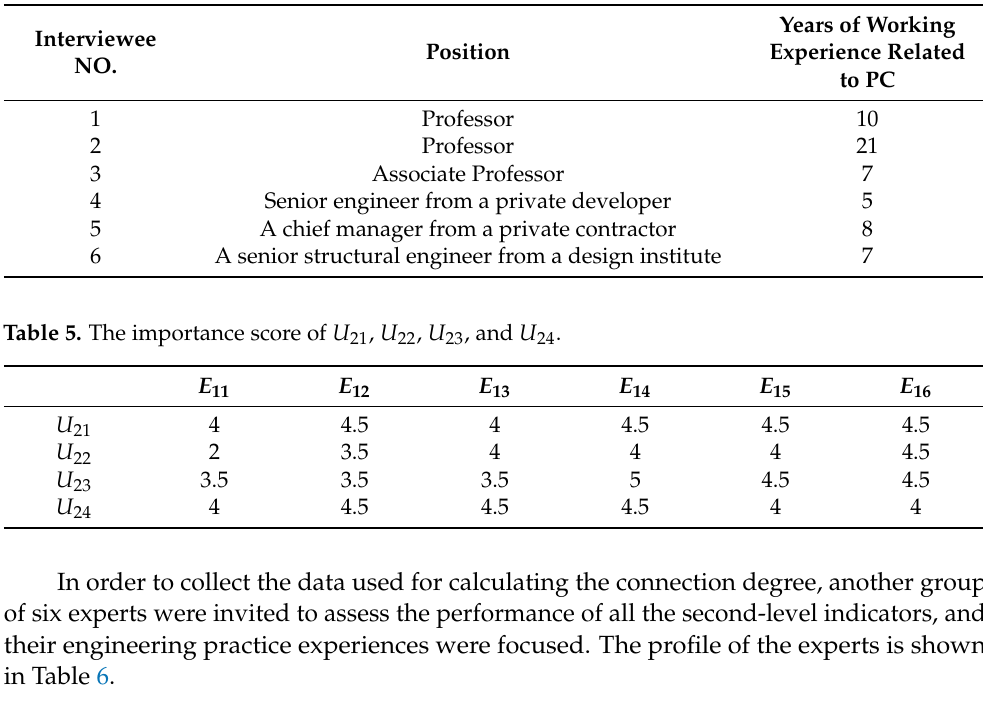
Table 6. Profile of the experts invited to access the performance of all the second-level indicators. Interviewee